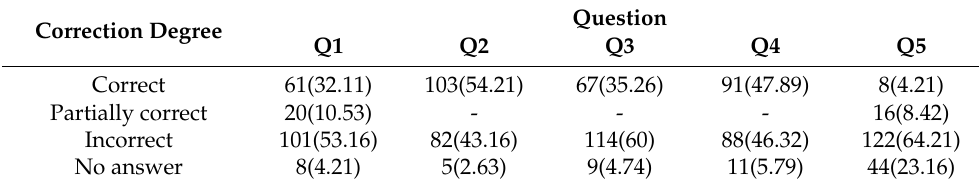
Table 1. Correction degree frequencies (percentage) of problems